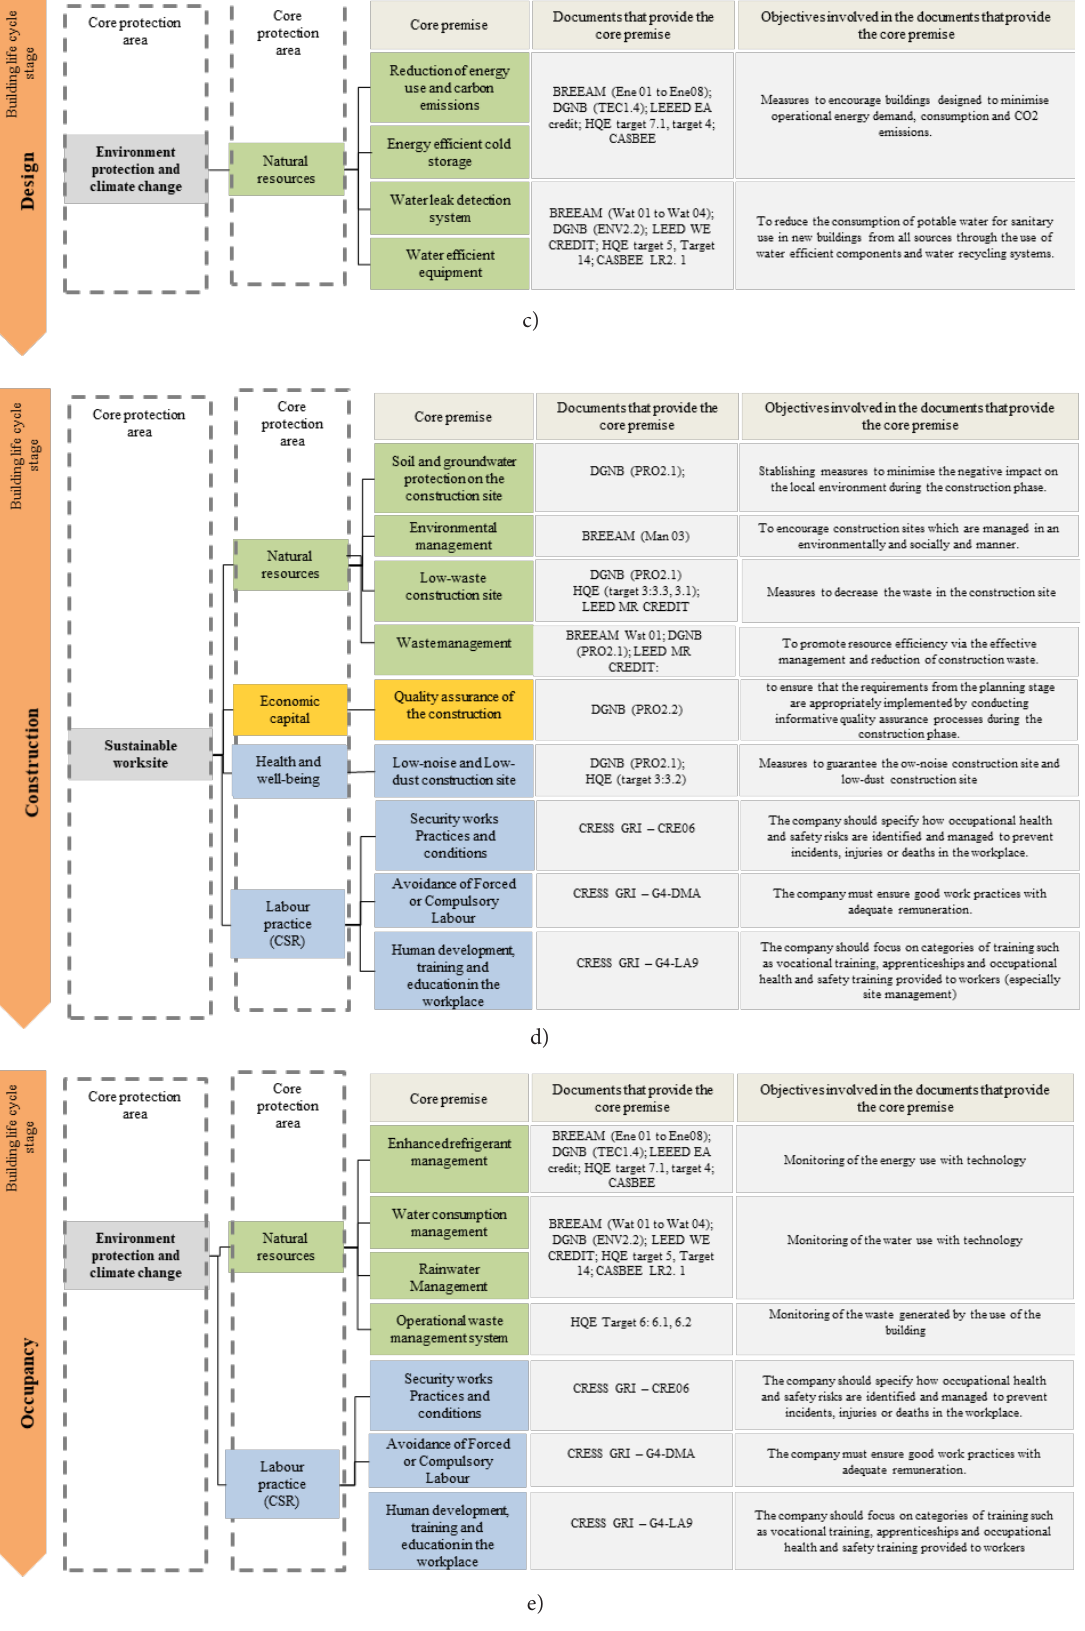
Figure 8. a − The core premises at the building’s planning phase (source: elaborated by the authors); b − The core premises at the building’s design phase (source: elaborated by the authors); c − The natural resources’ core premises at the building’s design phase (source: elaborated by the authors); d − The core premises at the building’s construction phase (source: elaborated by the authors); e − The core premises at the building’s occupancy phase (source: elaborated by the